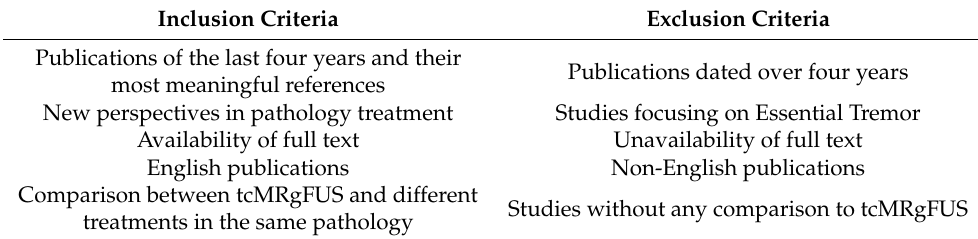
Table 1. Inclusion and exclusion criteria. Inclusion Criteria Exclusion Criteria Publications of the last four years and their most meaningful references New perspectives in pathology treatment Studies focusing on Essential Tremor Availability of full text Comparison between tcMRgFUS and different Studies without any comparison to treatments in the same pathology